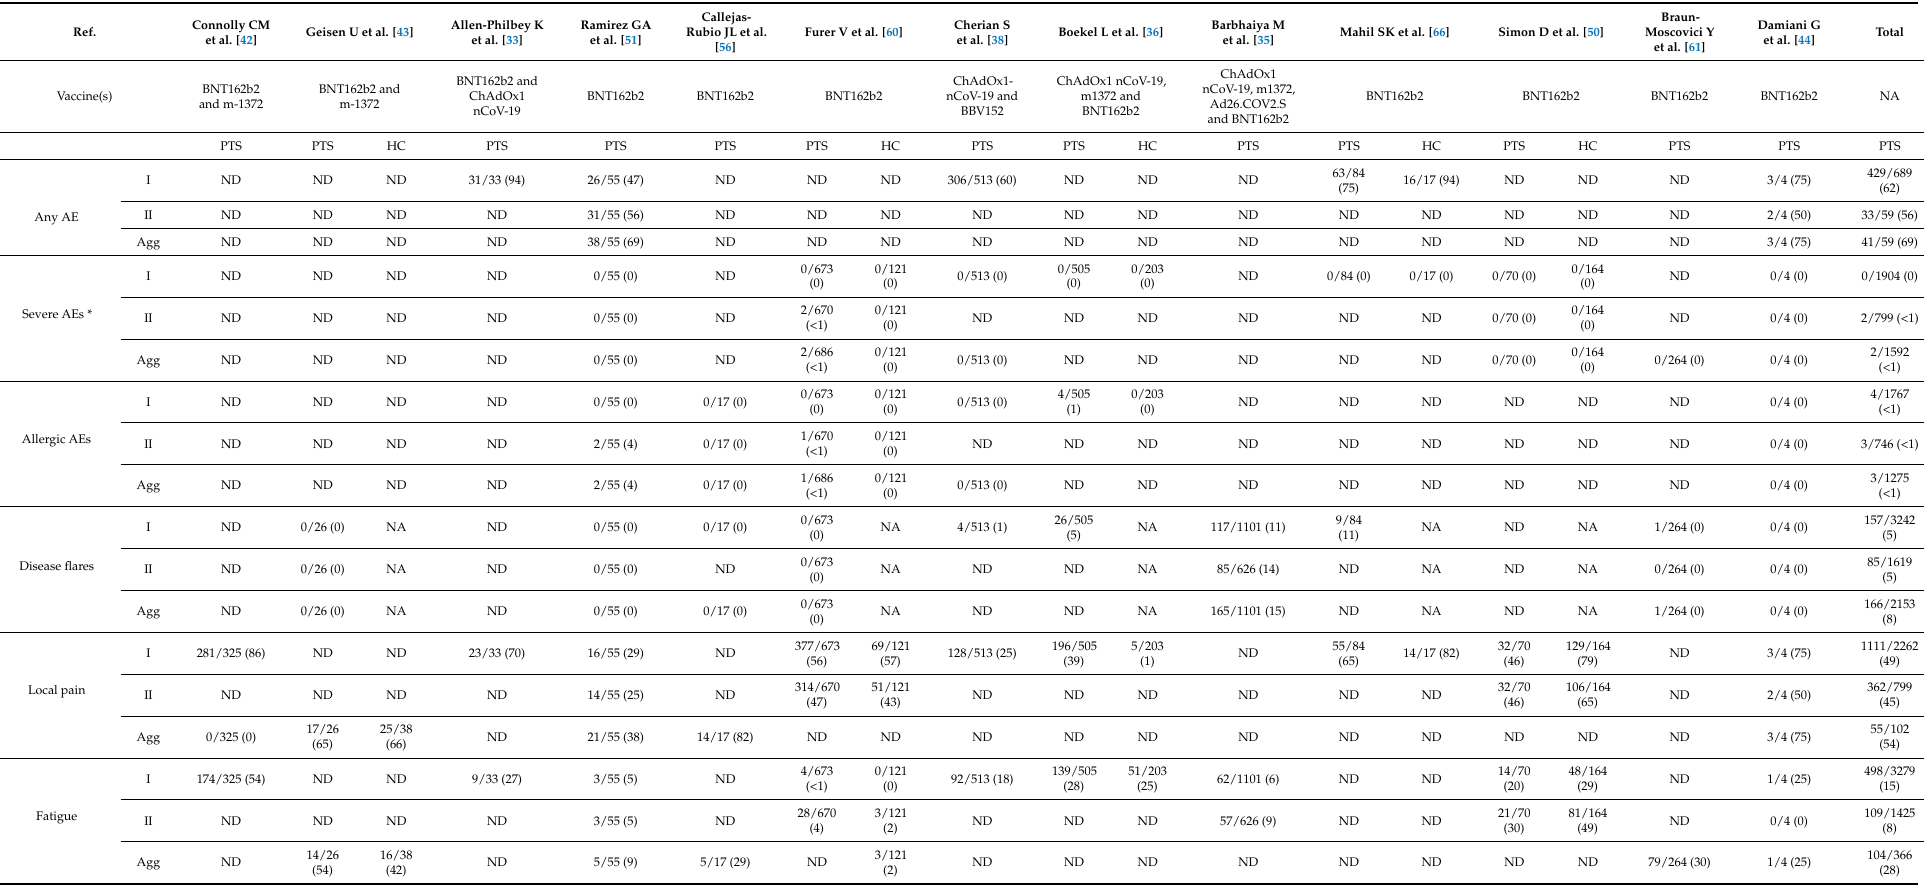
Table 3. Safety of vaccination in patients with autoimmune